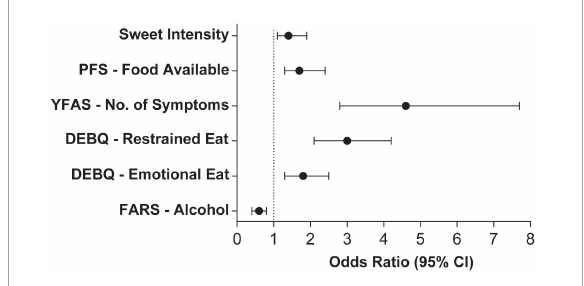
FIGURE1 Odds ratio and 95% confidence intervals of gustatory and psychometric variables that were significantly associated with the obesity group. Models were adjusted for age, gender, education level, and research center. Independent variables were standardized to Z-scores for effect size comparison. N = 396. PFS, Power of Food Scale; YFAS, Yale Food